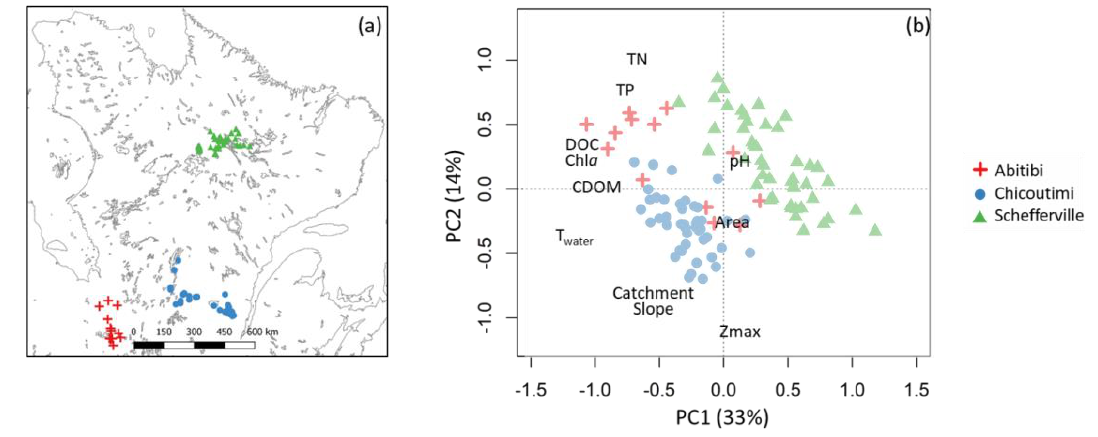
Figure 1: (a) Map of sampled lakes across three regions of boreal Quebec, Canada. (b) Lakes environmental principal component analysis (PCA) based on water quality and morphometric variables where the different symbols represent the three sampled regions. Abbreviations are as follows total phosphorus (TP); total nitrogen (TN); dissolved organic carbon (DOC); chlorophyll a (Chl- a ); coloured dissolved organic matter (CDOM); water temperature (T water ); lake maximum depth (Zmax); lake area